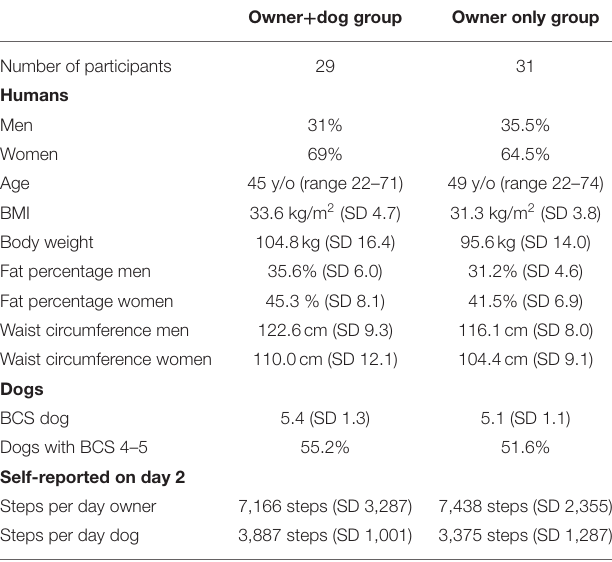
TABLE 1 | Baseline characteristics human-centered trial.